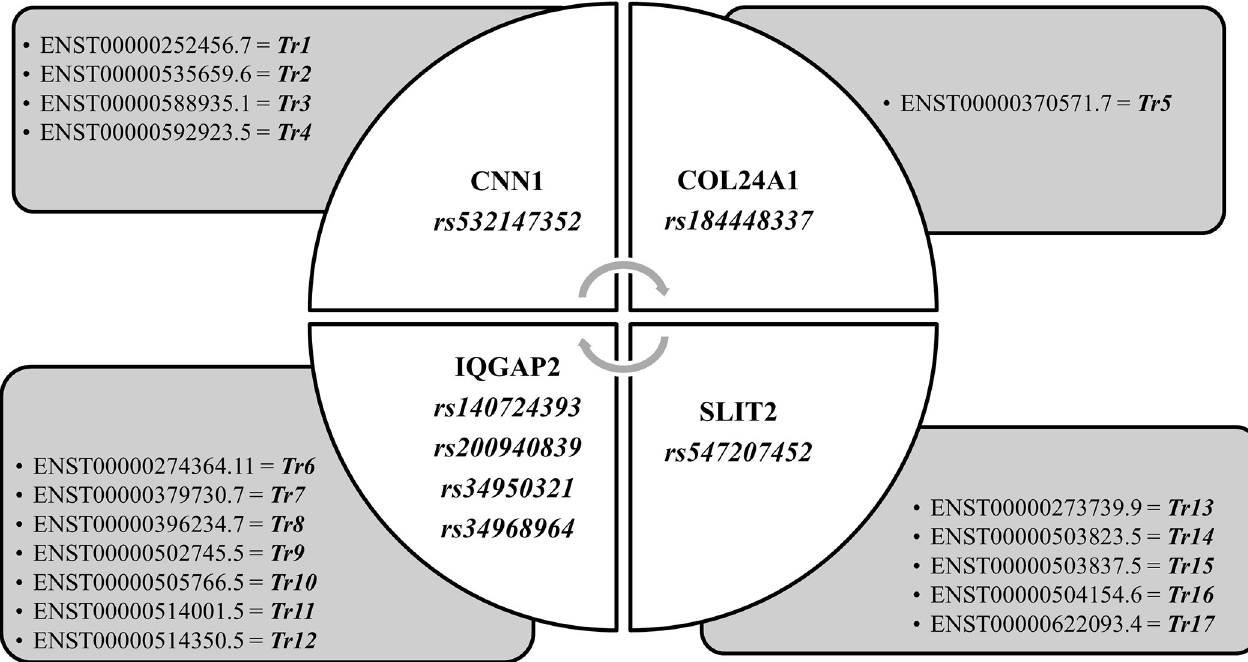
Fig 4. Distribution of rare nsSNPs based on transcript sequences. Filtered genes are shown based on pathogenic SNPs extracted through annotation strategies and their respective ENSEMBL transcripts versions ( Tr ).